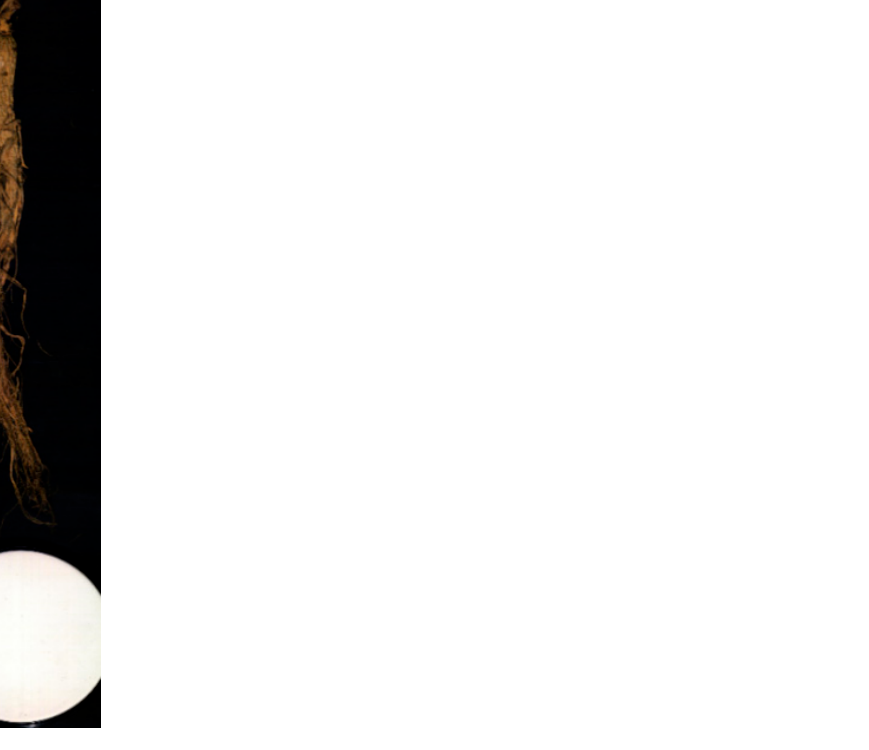
Figure 1. True color composite image extracted from hyperspectral image of ginseng sample.